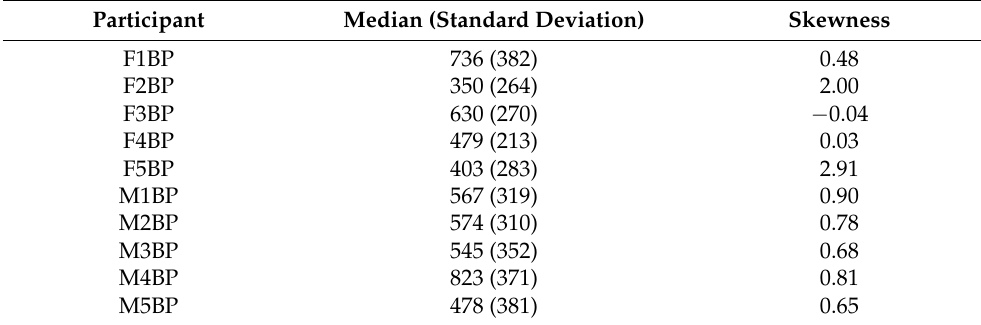
Table 1. Median (and standard deviation) in ms, and Pearson skewness of pause duration for the Brazilian participants of the Current-Set.